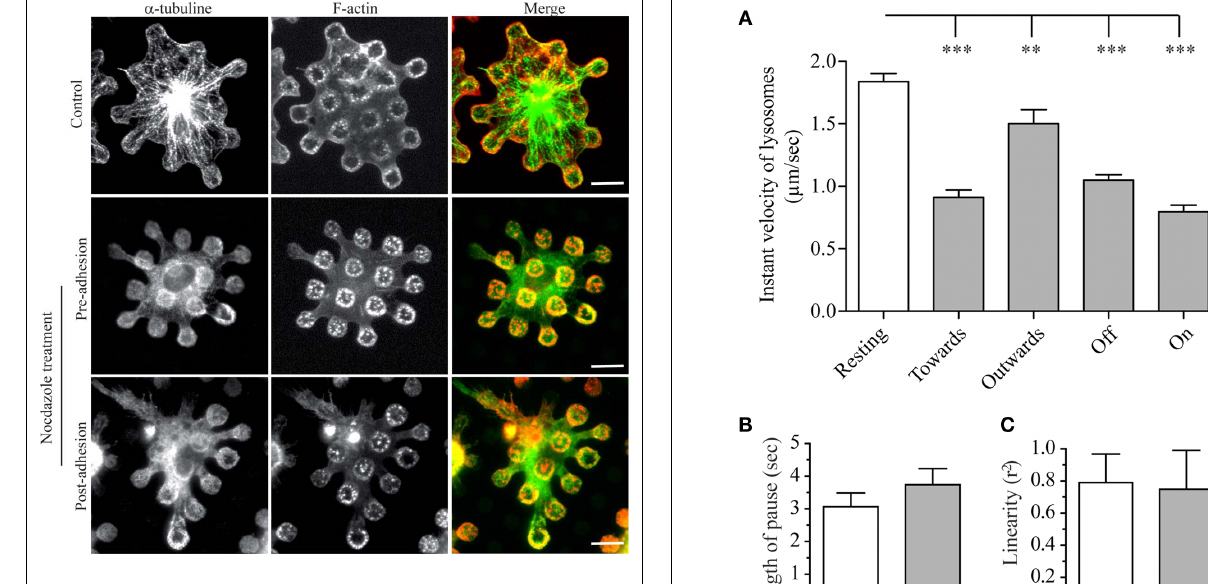
FIGURE 5 | Microtubules are dispensable for biogenesis of frustrated phagosomes and their stability. Bone-marrow derived macrophages from wild-type mice were treated or not (Control) with 10 μ M nocodazole either before (pre-adhesion) or after (post-adhesion) being layered on micro-patterned immune complexes. Cells were then fixed, permeabilized, and stained for F-actin and α -tubulin. Bars = 5 μ m.